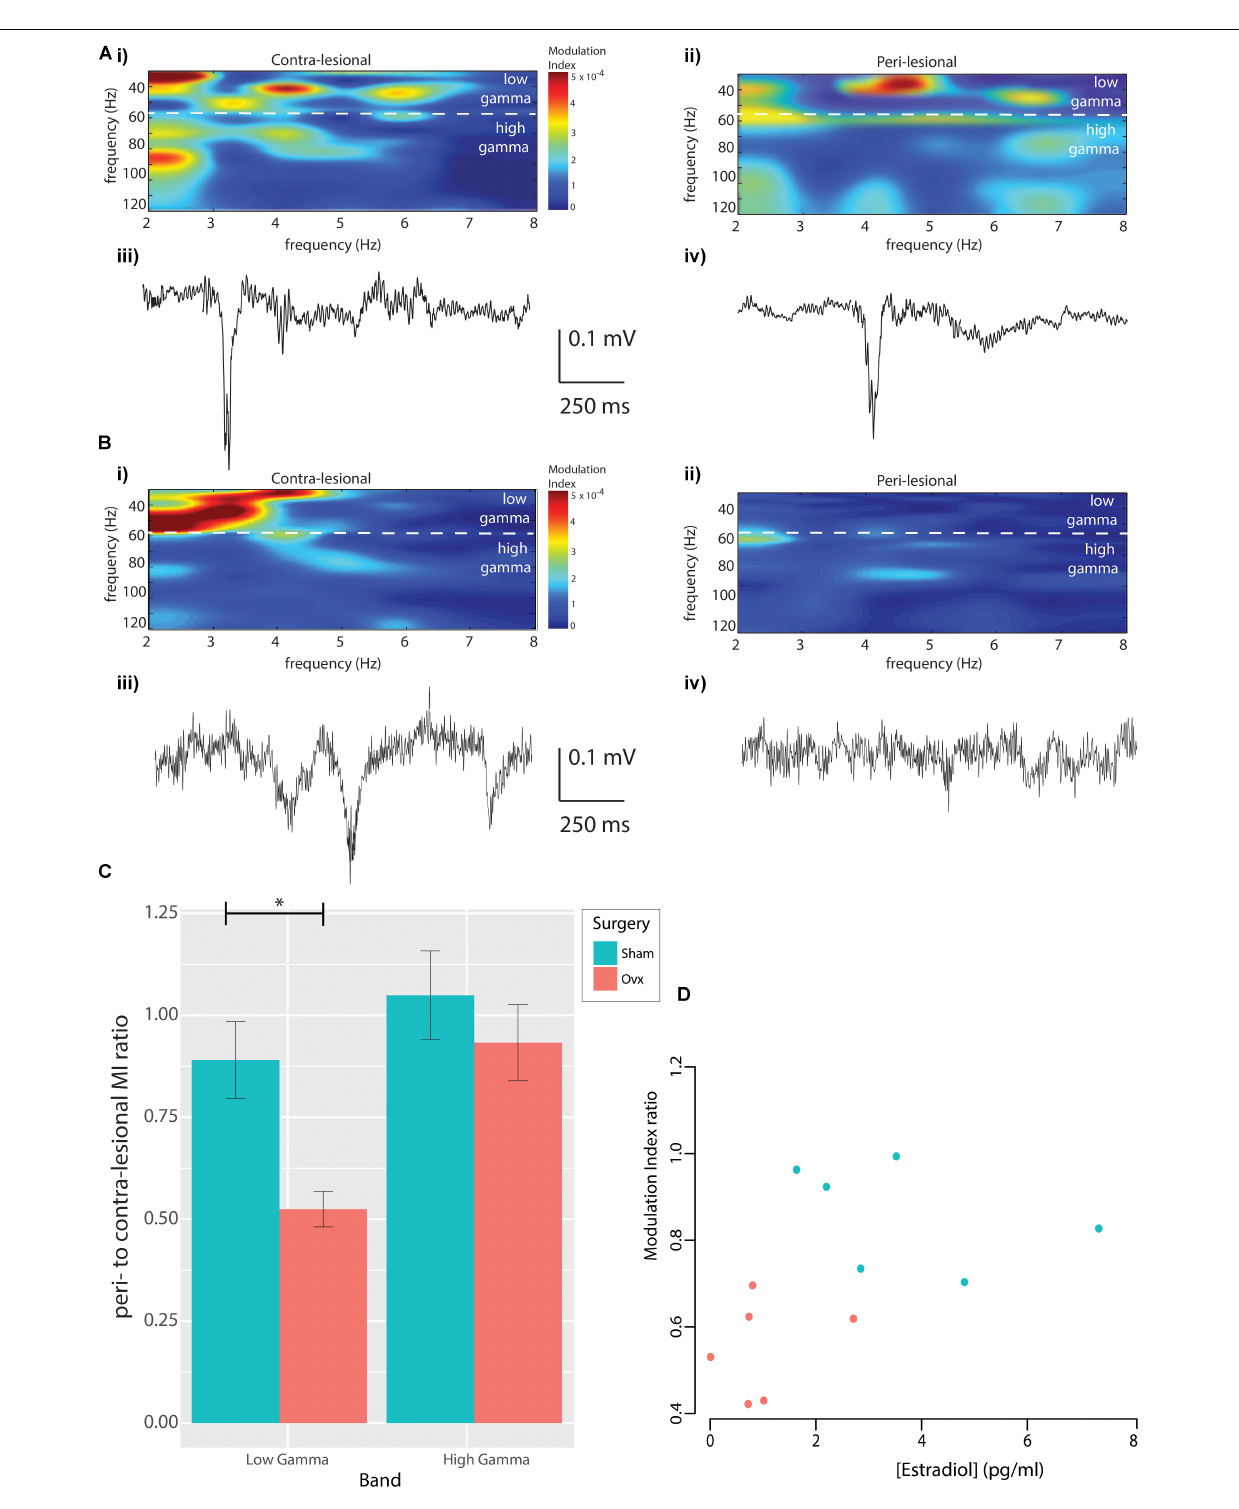
FIGURE 3 | Modulation index. (A) Modulation Index from contra-lesional (Ai) and peri-lesional (Aii) regions of a representative Sham rat, with representative raw data epochs from contra-lesional (Aiii) and ipsi-lesional (Aiv) regions of the same rat. (B) The corresponding data in an Ovx animal. (C) Population analysis revealed reduced peri-to-contralesional theta to low-gamma MI ratio in the Ovx vs. Sham cohort, whereas theta to high-gamma MI ratios were indistinguishable. (D) Positive correlation between peri-to-contra-lesional theta to low-gamma MI ratio and serum estradiol concentration at stroke-induction (Spearman’s correlation, rho = 0.67, p =